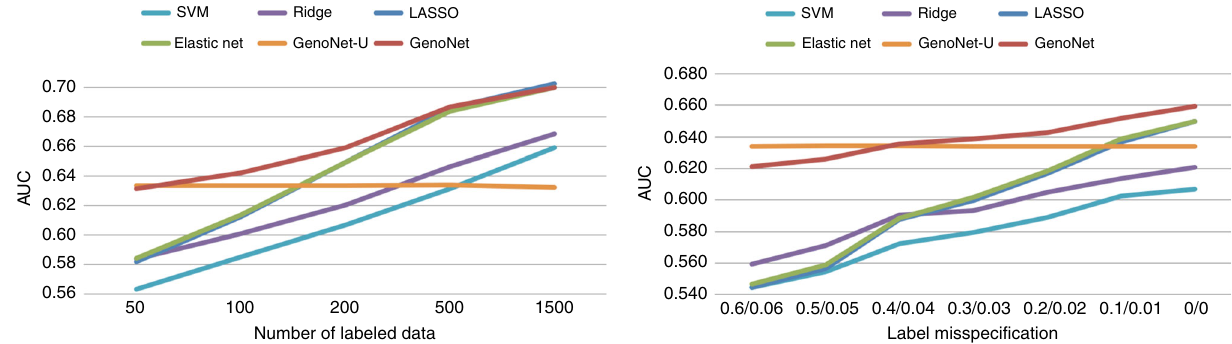
Fig. 8 Semi-supervised vs. supervised vs. unsupervised approach. Left panel: AUROC comparison with varying number of labeled variants ( m = 50 – 1500). For each replicate, m variants in the K562 Leukemia Cells data are randomly selected as training data in the supervised/semi-supervised methods, and the rest are used as test data. Each curve presents the average AUROC on the test data based on 1000 replicates. Right panel: AUROC comparison with various degrees of label misspeci fi cation using m = 200 labeled variants (high misspeci fi cation to low misspeci fi cation from left to right). GenoNet: the proposed semi-supervised method; GenoNet-U: unsupervised GenoNet, i.e. using unlabeled data only ( γ I = ∞ ); Elastic-net (supervised GenoNet), LASSO, Ridge regression were implemented using the “ glmnet ” R package, and SVM was implemented using the “ e1071 ” R package. The tuning parameters were chosen using